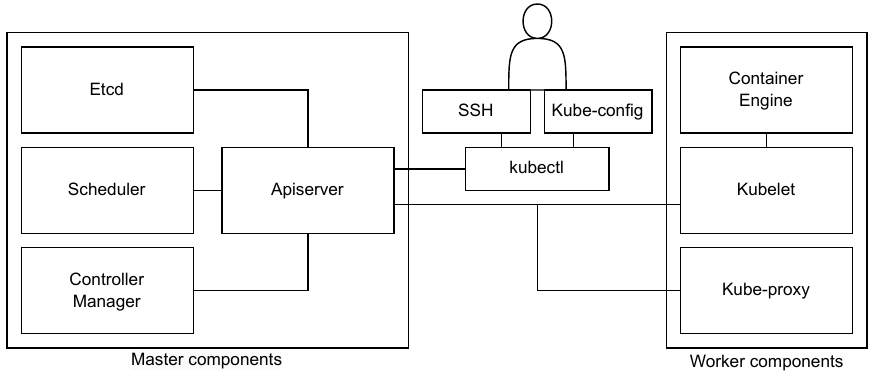
Figure 3. Kubernetes